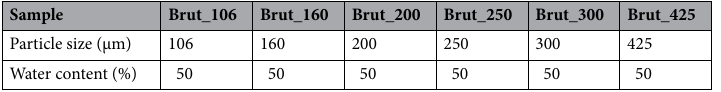
Table 1. The six samples prepared for studying the effect of particle